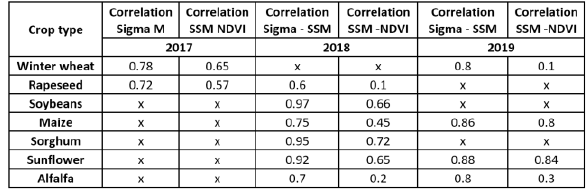
Table 1. Volumetric soil moisture evaluation based on SAR sensor response and NDVI